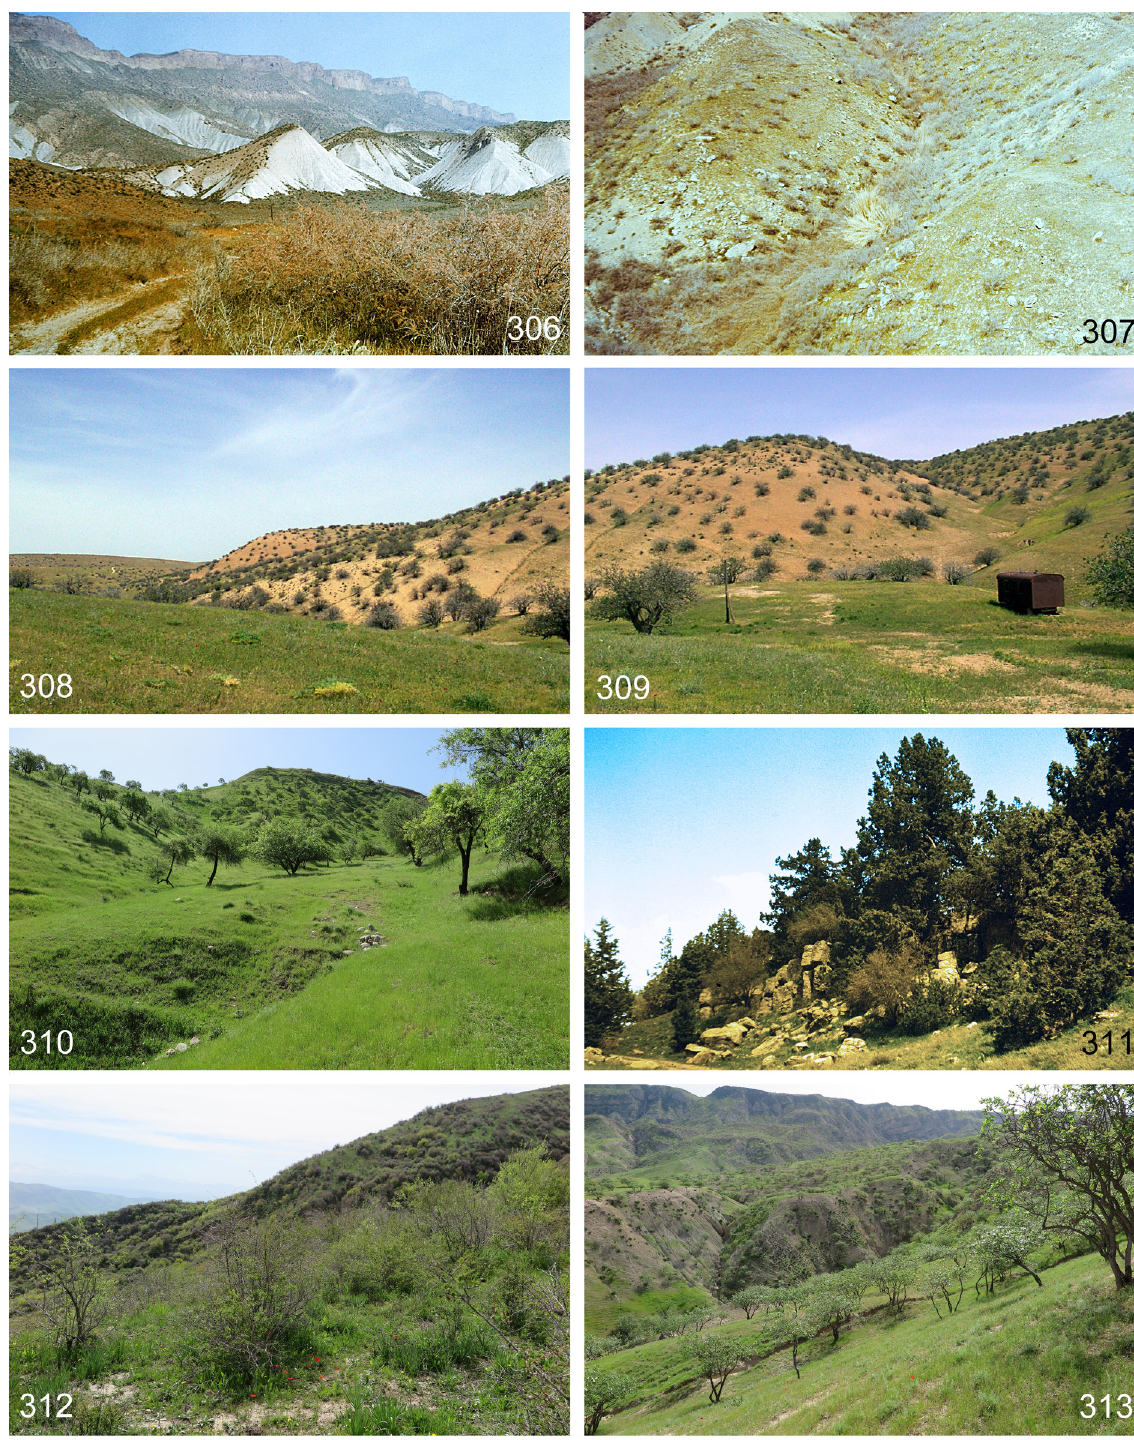
Figs 306–313. Anemesia spp., habitats of A. birulai (Spassky, 1937) (306–309), A. pococki sp. nov. (306–307), A. tubifex (Pocock, 1889) (306–307), A. andreevae sp. nov. (310–311), A. oxiana sp.